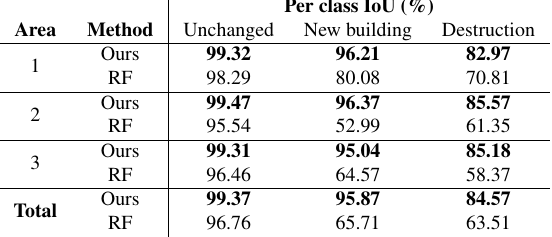
Table 4. Per area IoU scores (best in bold) of our Siamese KPConv network compared to RF + hand-crafted